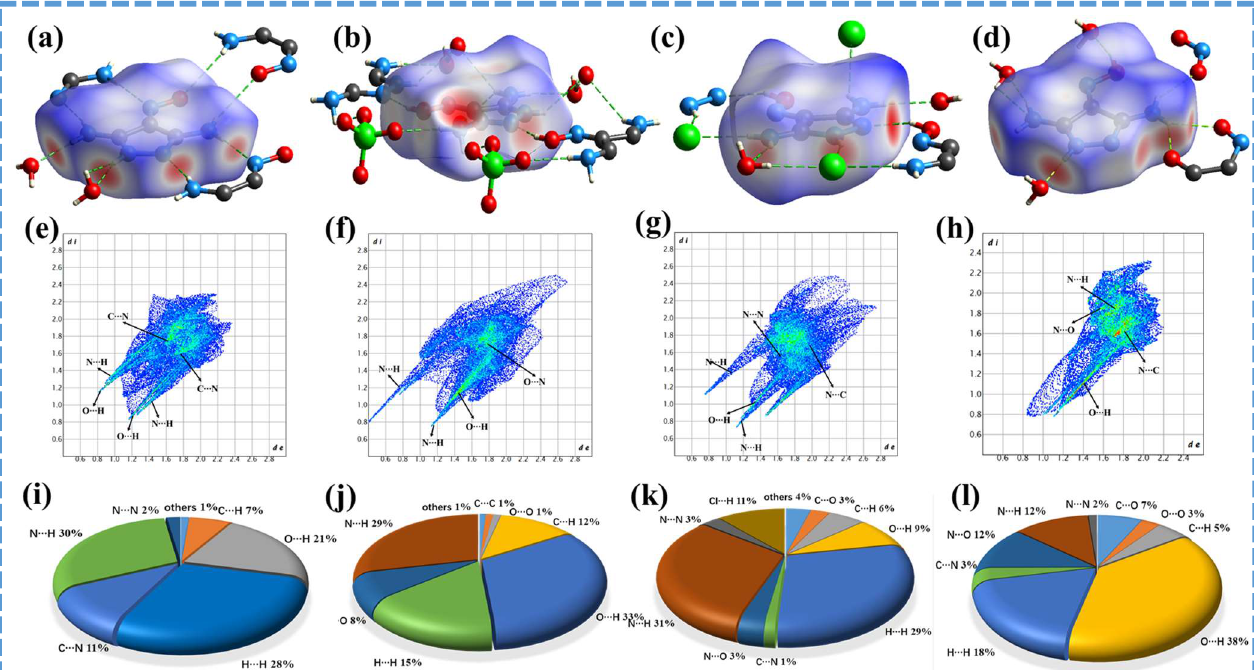
Figure 5. Hirshfeld surfaces ( a–d ), 2D fingerprint plots ( e–h ), and the atomic-to-atomic contact percentage contribution ( i–l ) for crystals DAPO·2H 2 O, DAPOC·H 2 O, DAPOP·H 2 O, and DAPOT·3H 2 O, respectively.